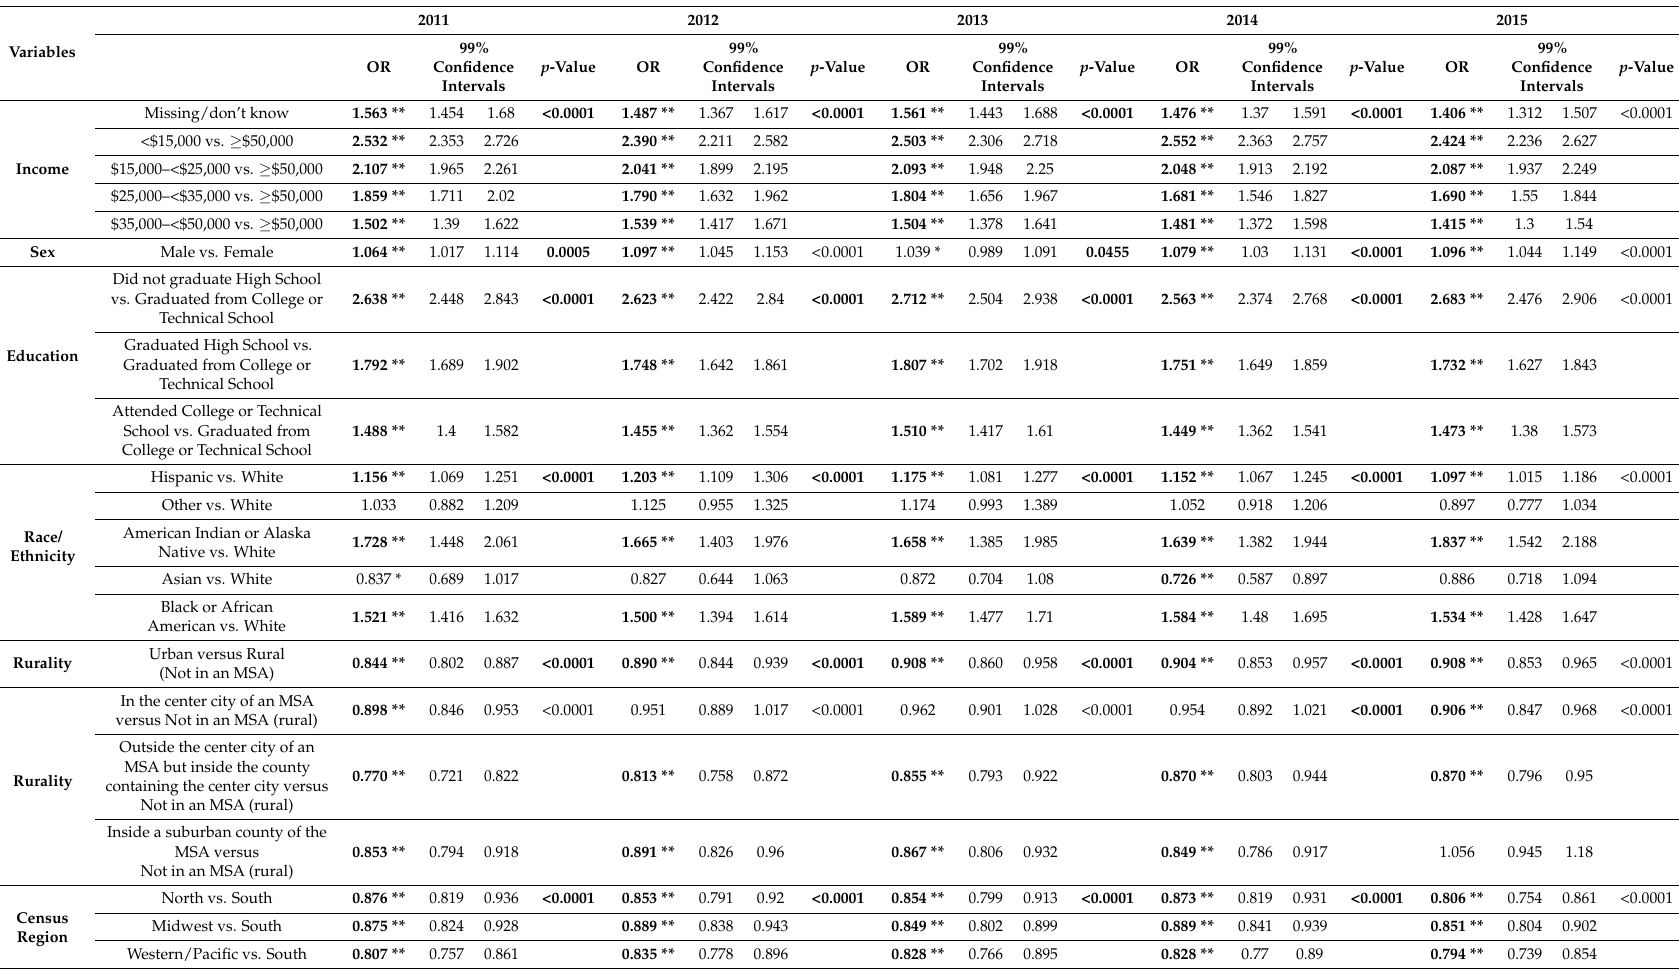
Table 2. Unadjusted analysis for diagnosed